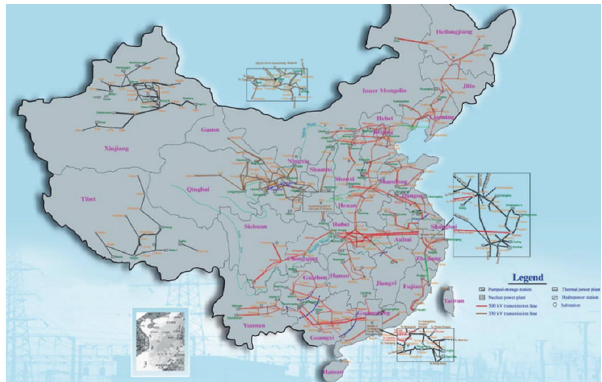
Figure 2: Map of Chinese power grid, adopted from